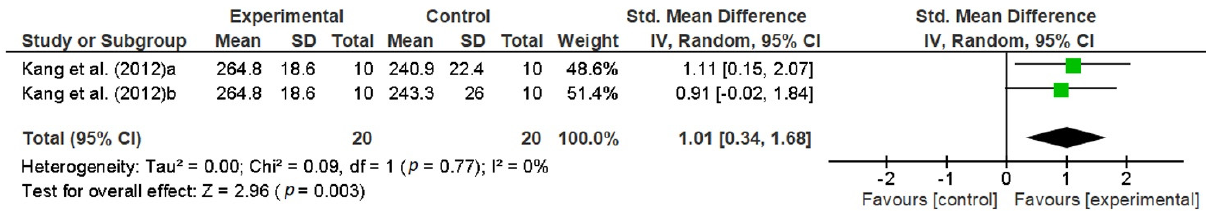
Figure 5. Pooled standardized mean differences and overall effect size (95% CI) on 6MWT test immediately after the in- tervention in Kang et al.’s study. (a) VR treadmill group versus control group. (b) VR treadmill group versus treadmill group.